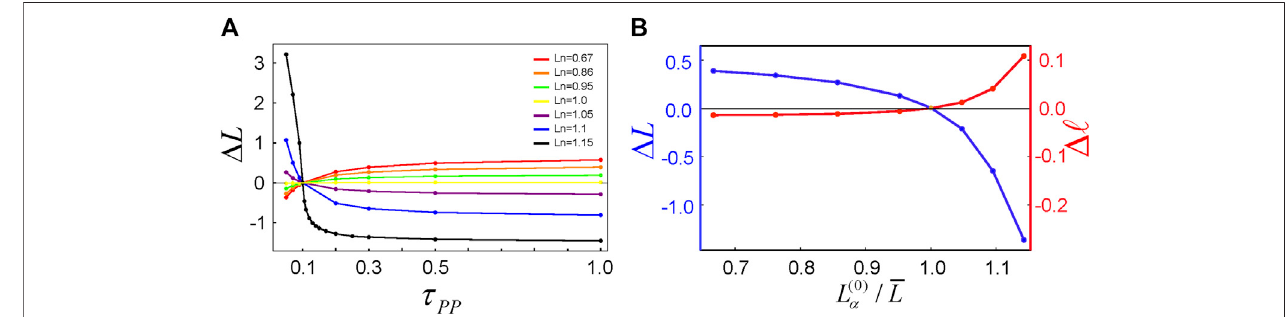
FIGURE2|(A) Thelengthdifference( Δ L )ofthecompartmentboundarybetweentheinitialand fi nalstatesofthesheetasafunctionof τ PP and L n .Thequantity L n is given by L ( 0 ) α / L . The quantity L ( (cid:1) 5.56) is the mean perimeter length of P cells in the initial state. (B) Plots of Δ L and the mean length difference ( Δ ℓ ) of cell boundaries betweenPcellsasafunctionof L ( 0 ) α / L .Inthissimulation, τ PP waschangedfrom τ PP (cid:1) 0 . 1(default)to τ PP (cid:1) 0 . 3att (cid:1) 0.Theparametervaluesusedherearethesameasin Figure 1 , except for the values of the parameters τ PP and L ( 0 ) α . In this simulation τ PP is varied from 0.05 to 1.0, and L ( 0 ) α is varied from 4.4 to